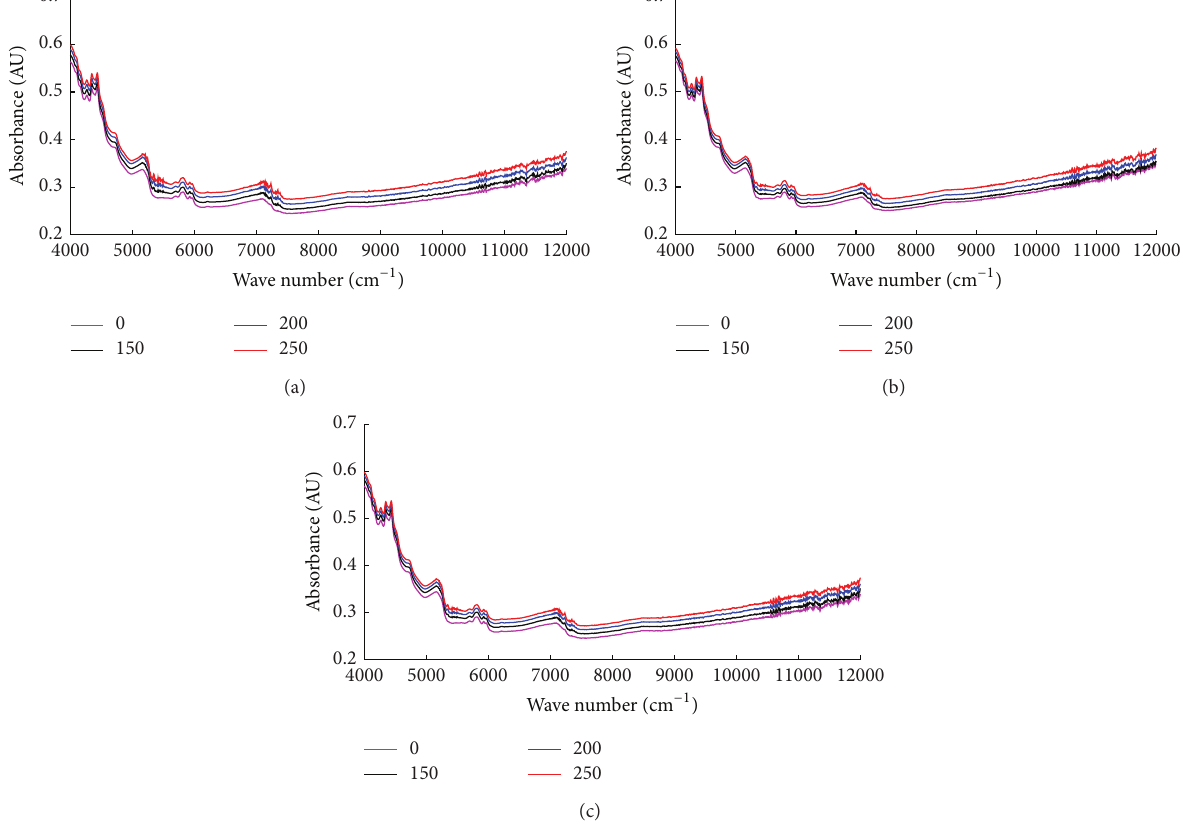
Figure 1: Spectral curves for each physiological race of wheat stripe rust pathogen which was irradiated under different UV-B intensities. (a) was for CYR31, (b) was for CYR32, and (c) was for CYR33. The unit of UV-B intensity is 𝜇 w/cm 2